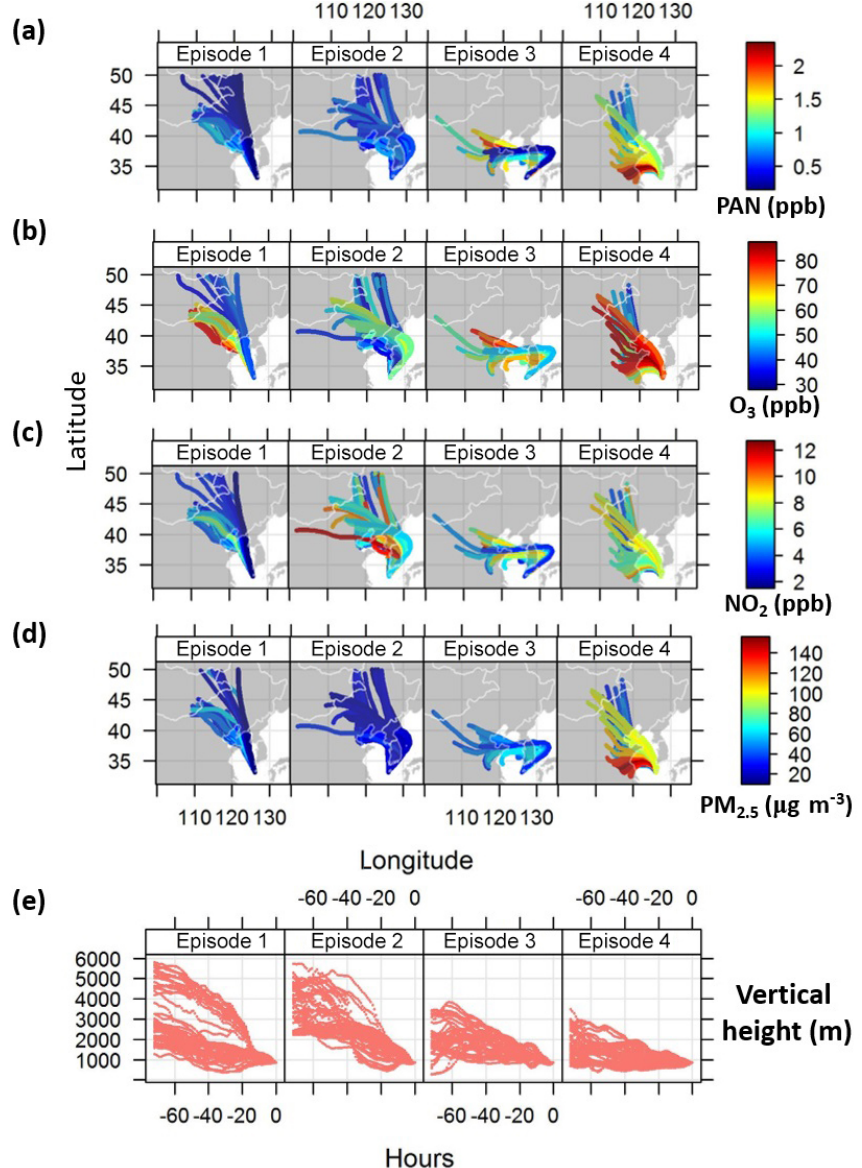
Figure 4. The three-day NOAA HYSPLIT backward trajectories of air masses for every 1h observed at GCO during episode 1 (31 October– 2 November), episode 2 (28–29 October), episode 3 (20–21 October), and episode 4 (4–5 November). They are colored according to the level of (a) PAN, (b) O 3 , (c) NO 2 , and (d) PM 2 . 5 at GCO at the time of the trajectory initialization. The trajectories north of 50 ◦ N are not shown. For these horizontal trajectories, (e) vertical heights are